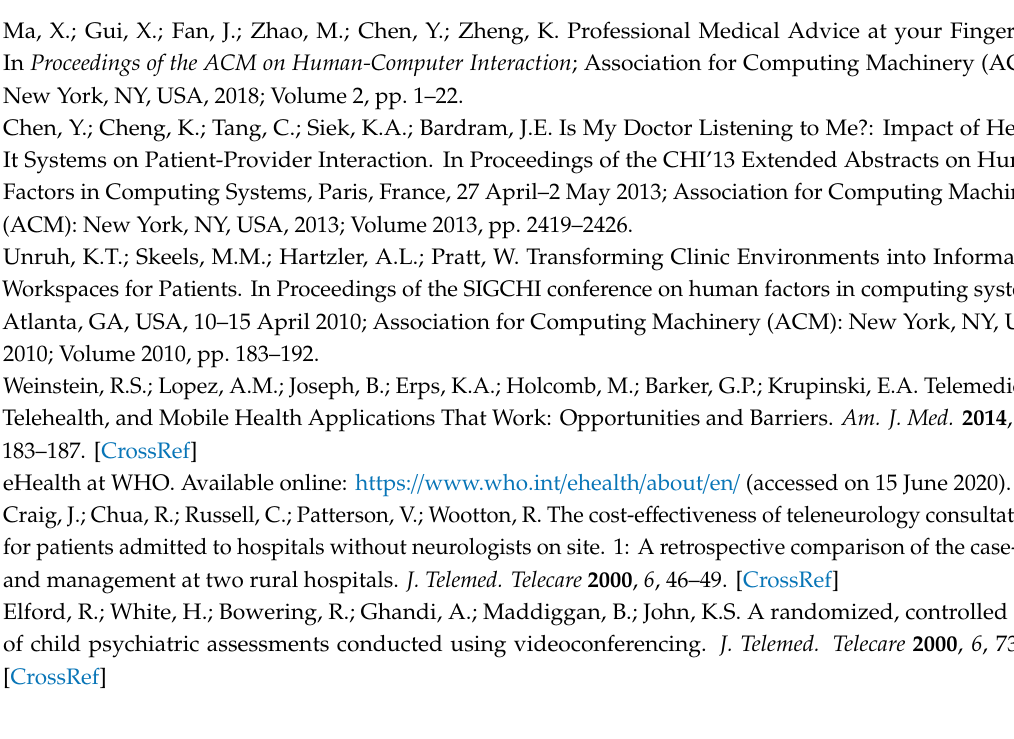
Figure S1: Survey on Acceptance and Adoption Behavior of Mobile Medical Treatment